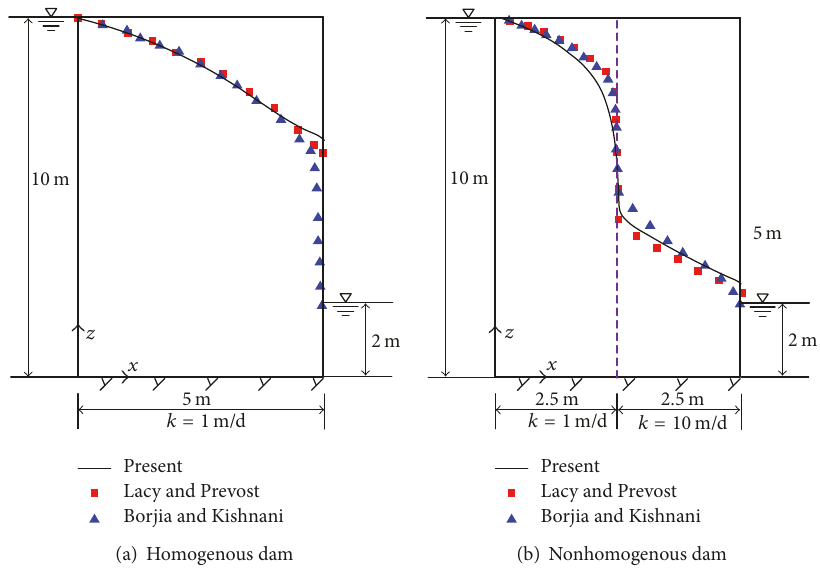
Figure 6: Verification on saturated steady seepage